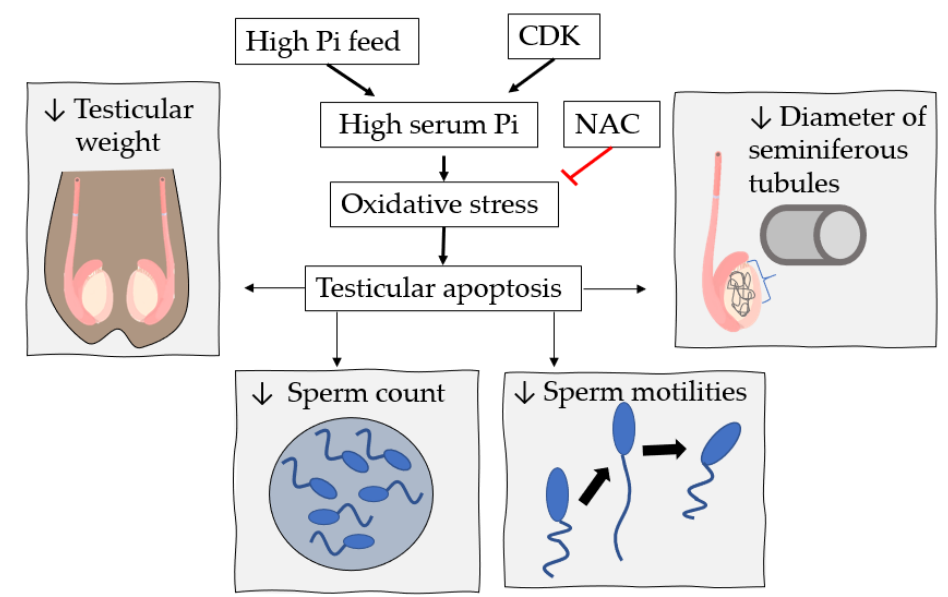
Figure 4. High Pi impairs testicular function by oxidative stress. A high Pi diet, chronic kidney disease (CKD), or both in WKY rats [60] or C57BL/6 mice [59] increases serum Pi, oxidative stress, and apoptosis in the testicles. Testicular apoptosis induced by oxidative stress promotes a decrease in testicular weight, sperm count, sperm motilities, and seminiferous tubule diameter [59,60]. Nevertheless, this effect is restored by supplementation with a potent oxidative species scavenger, N-acetylcysteine (NAC) [59].